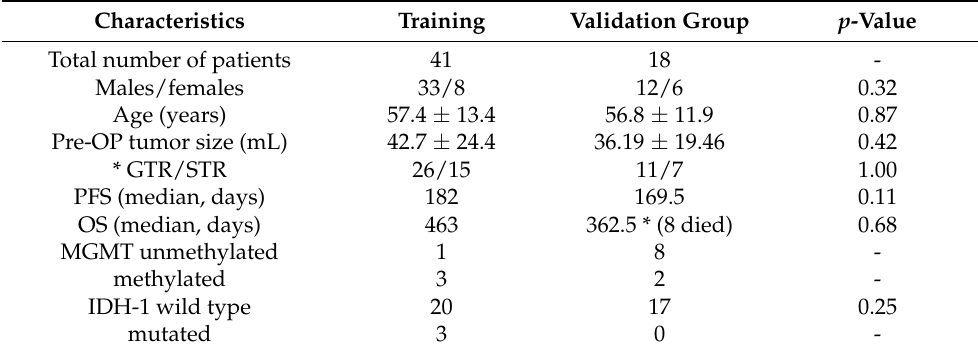
Table 1. General